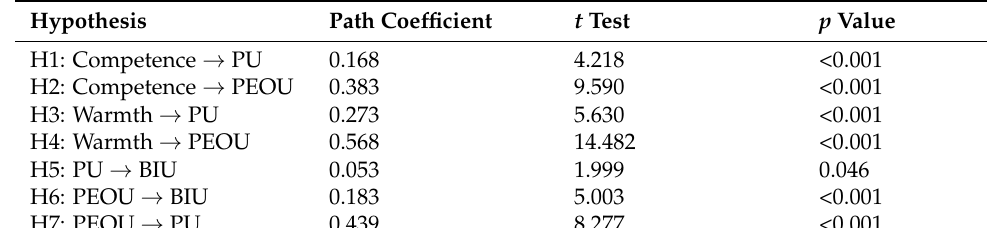
Table 5. Hypothesis testing.